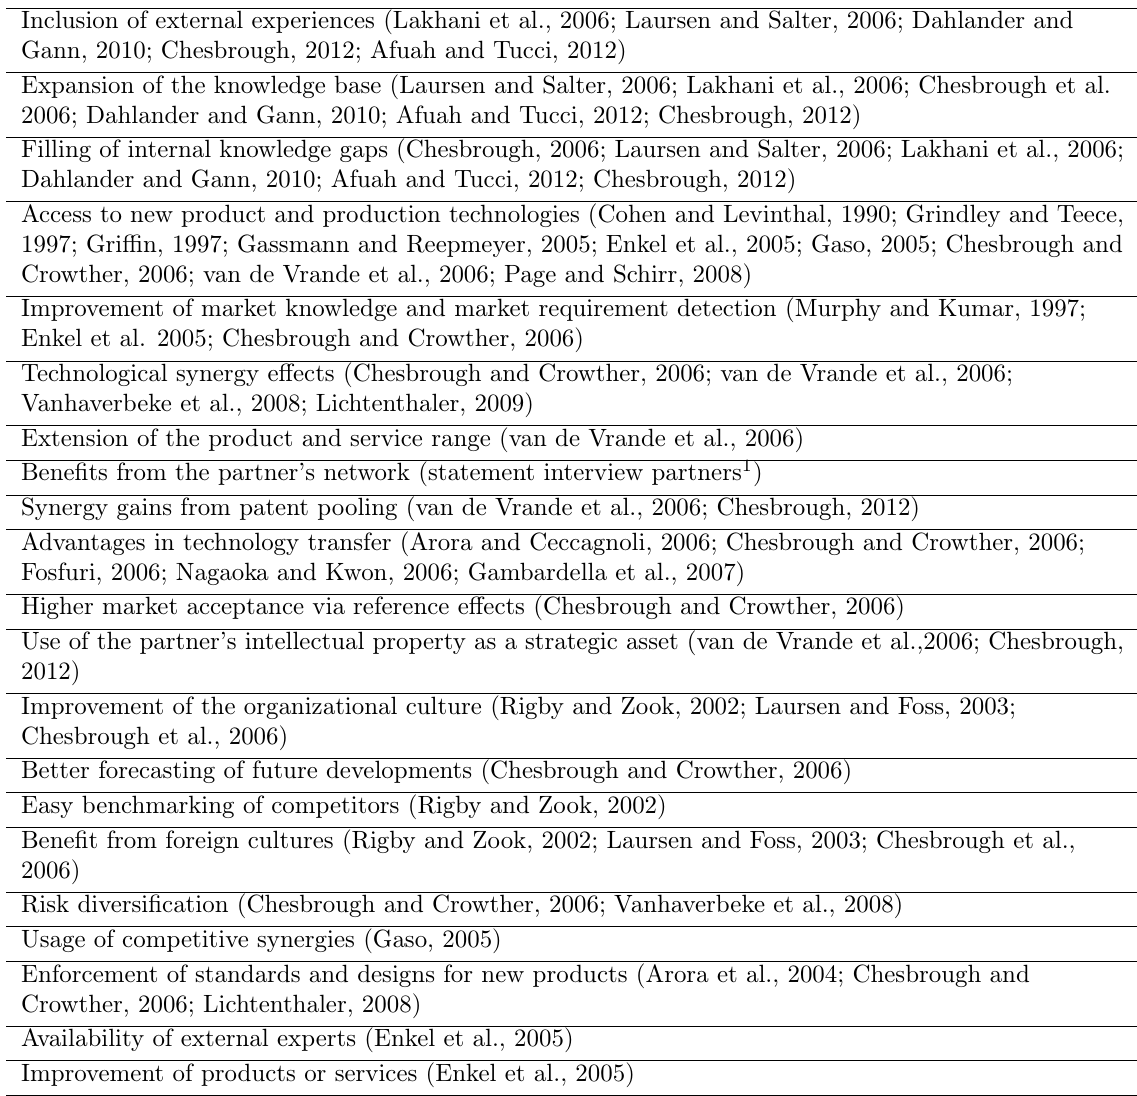
Table 1. Organizational benefits of open innovation. Organizational